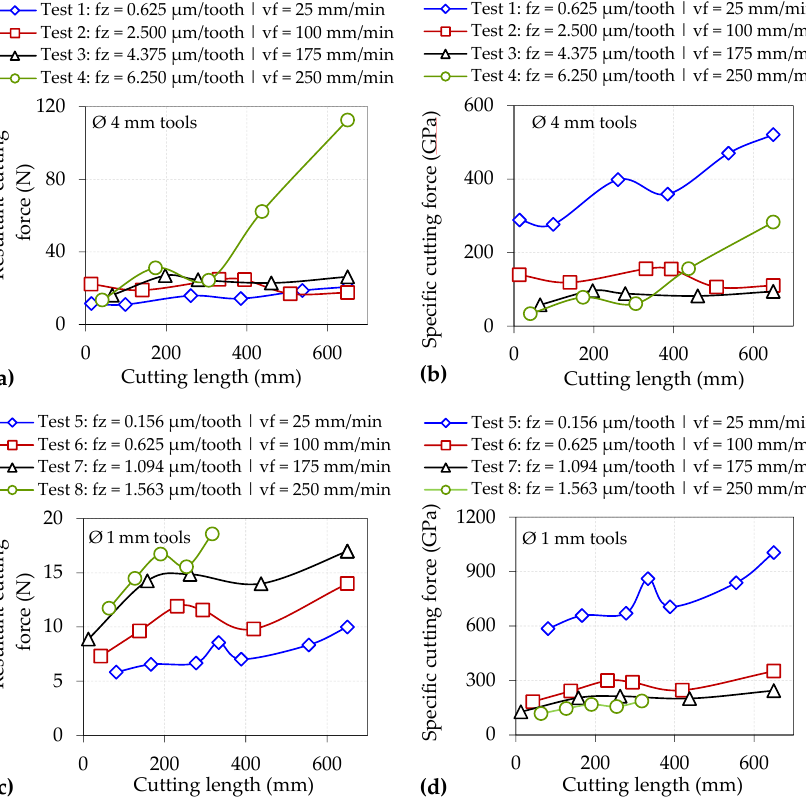
Figure 10. Resultant and specific cutting forces for tests using: ( a , b ) Ø 4 mm and ( c , d ) Ø 1 mm end-mills.